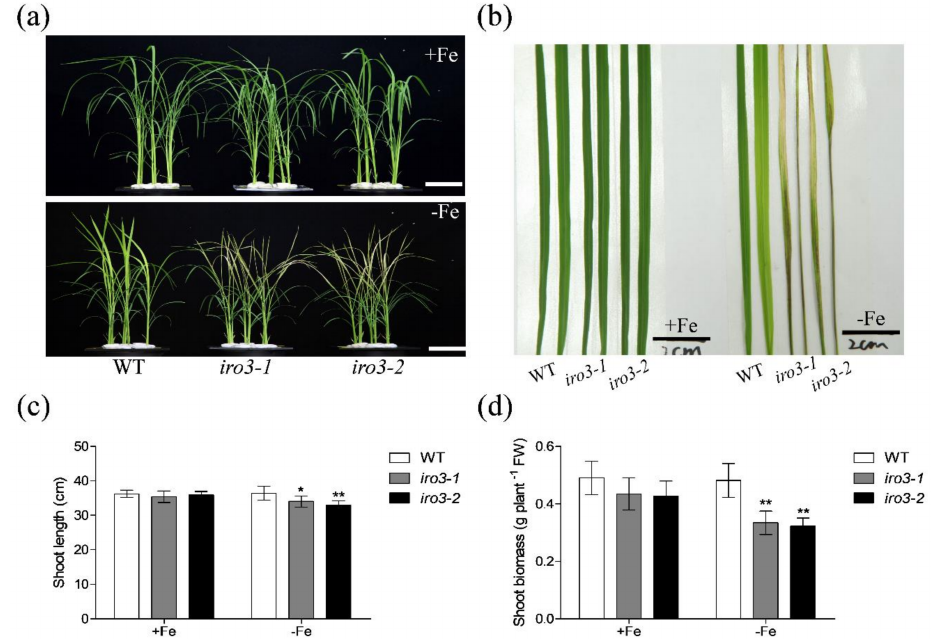
Figure 2. Shoot phenotype analysis of iro3 mutants. ( a ) Shoot growth performance of wild type (WT) and iro3 mutants under + Fe or − Fe conditions. ( b ) The two newly developed leaves of WT and iro3 mutants under + Fe or − Fe conditions. ( c ) Shoot length of WT and iro3 mutants. ( d ) Shoot biomass of WT and iro3 mutants. Fourteen-day-old seedlings were transferred to Fe-deficient conditions ( − Fe) or Fe-su ffi cient conditions ( + Fe) for 8 d. The iro3-1 mutant contains an insertion of ‘A’; the iro3-2 mutant contains an insertion of ‘T’. Data are given as the means ± SD of six biological replicates. All data were compared with the WT. Asterisks indicate significant di ff erences of WT and iro3 mutants based on two-tailed Student’s t test (* p < 0.05, ** p < 0.01). Bars = 5 cm in ( a ) and 2 cm in ( b ).